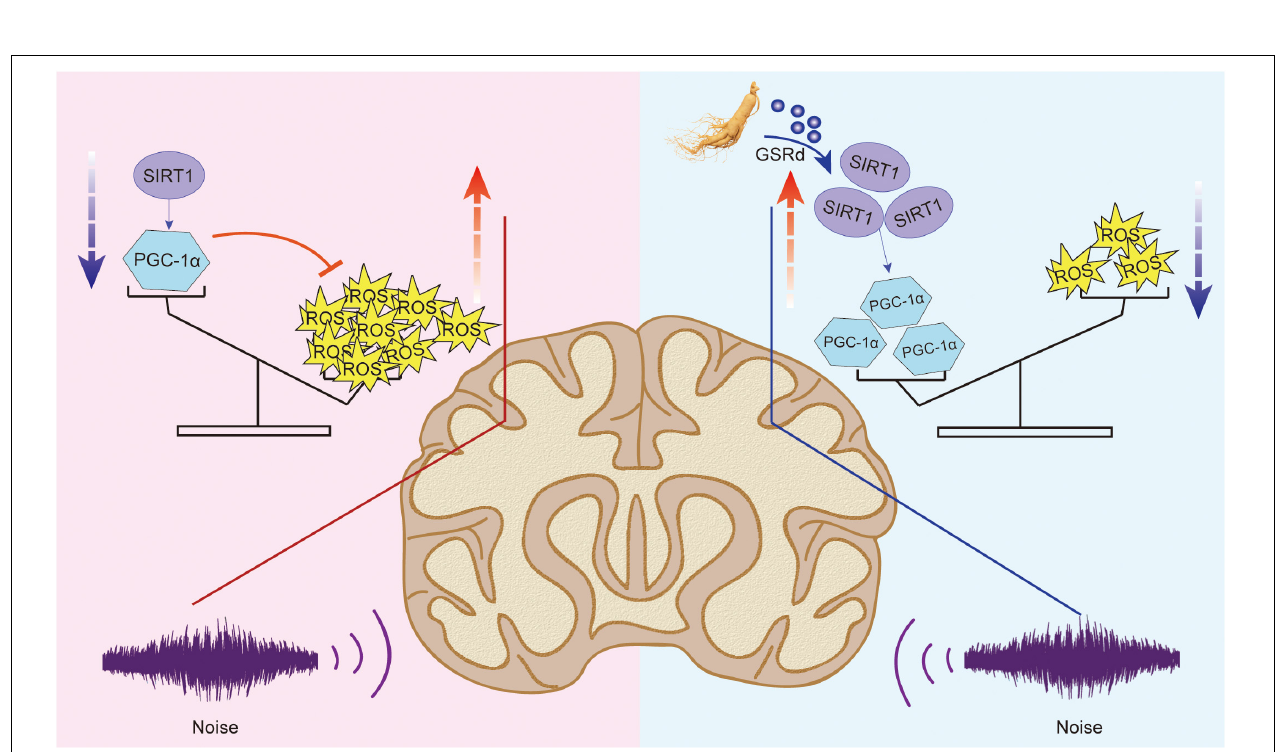
FIGURE 7 | Protective mechanism of GSRd on auditory cortex injury induced by military helicopter noise.